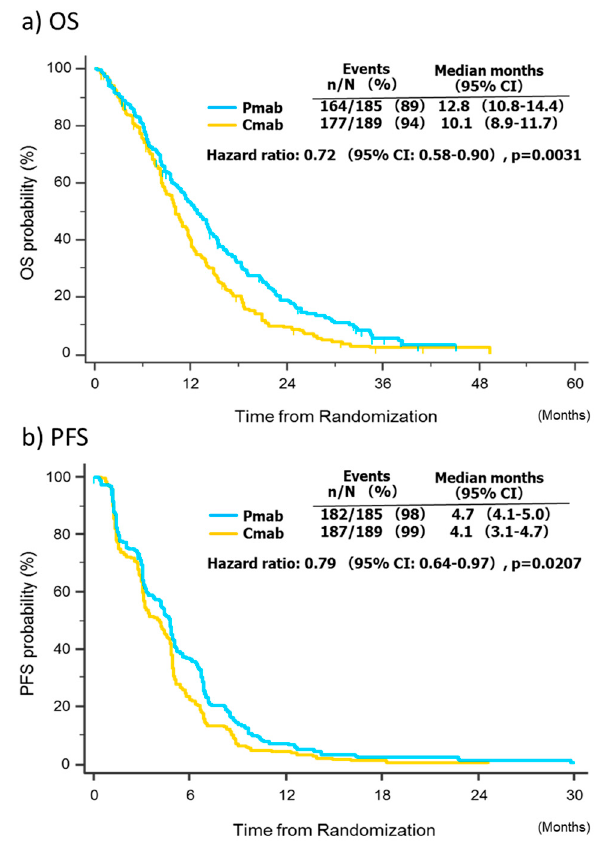
Figure 2. Survival analysis. Abbreviations: CI , confidence interval; Cmab, cetuximab; Pmab, panitumumab; OS, overall survival; PFS, progression-free survival.